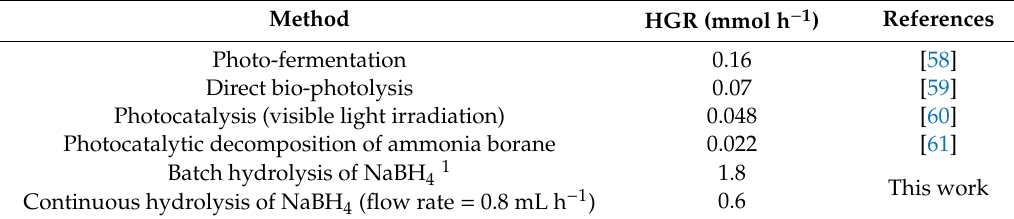
Table 5. Comparison of HGR using di ff erent processes.